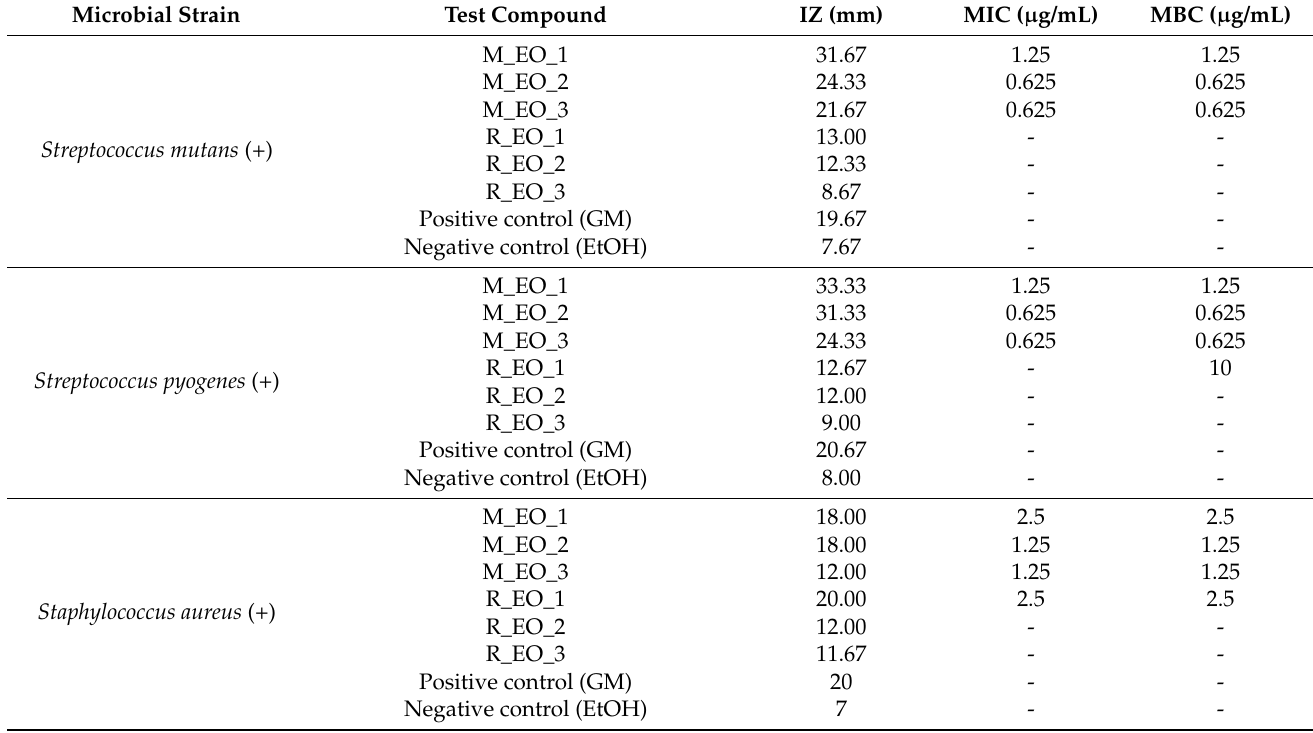
Table 4. The results of antibacterial activity of M. piperita and R. officinalis essential